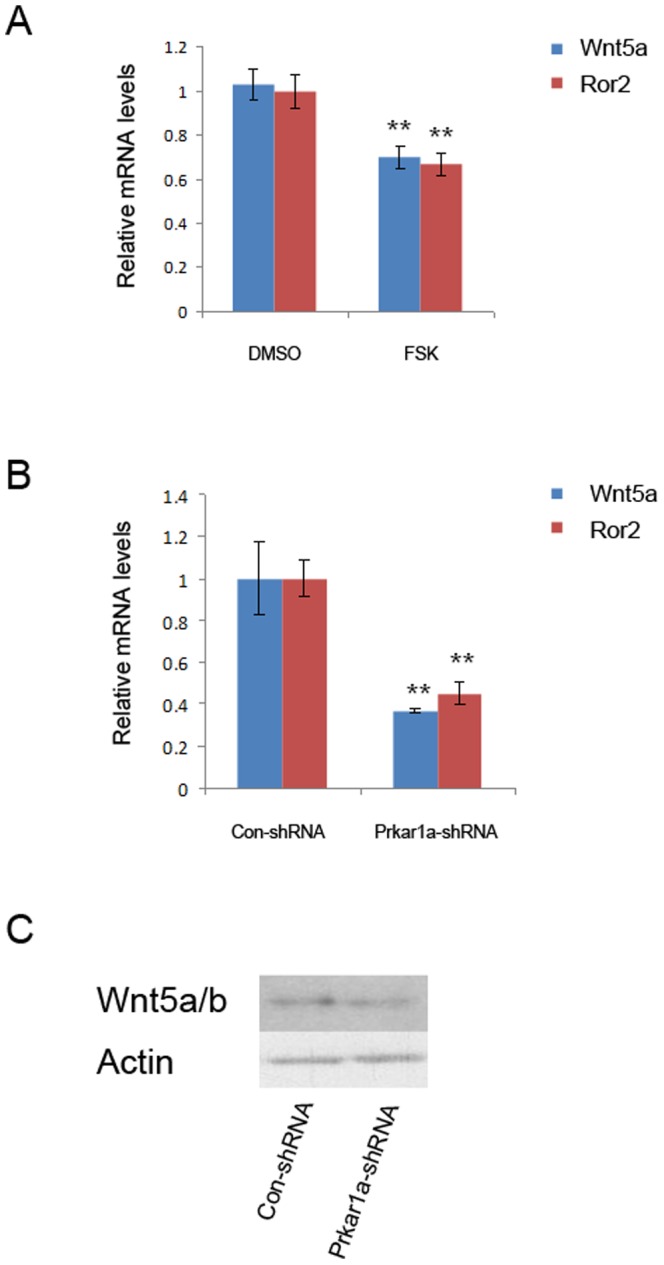
PKA activation represses Wnt5a/Ror2 pathway.A. and B. mRNA expression of Wnt5a and Ror2 was determined using QPCR analysis in MC3T3-E1 cells treated with FSK (A) or with Prkar1a knockdown (B) (** P<0.01 versus DMSO or control shRNA treated cells). Error bars represent standard deviation. C. 20 ug of protein lysates from MC3T3-E1 cells were analyzed for Wnt5a/b by Western blotting. Actin was used as the internal control. This experiment was repeated at least twice with similar results, and a representative blot is shown.